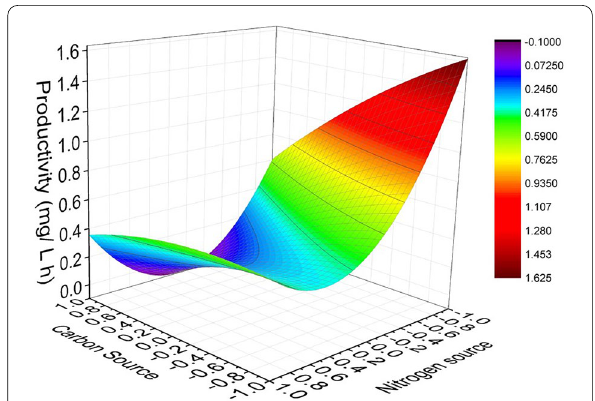
Fig. 2 Response surface representing the effect of carbon and nitrogen concentration in culture medium on PHB productivity